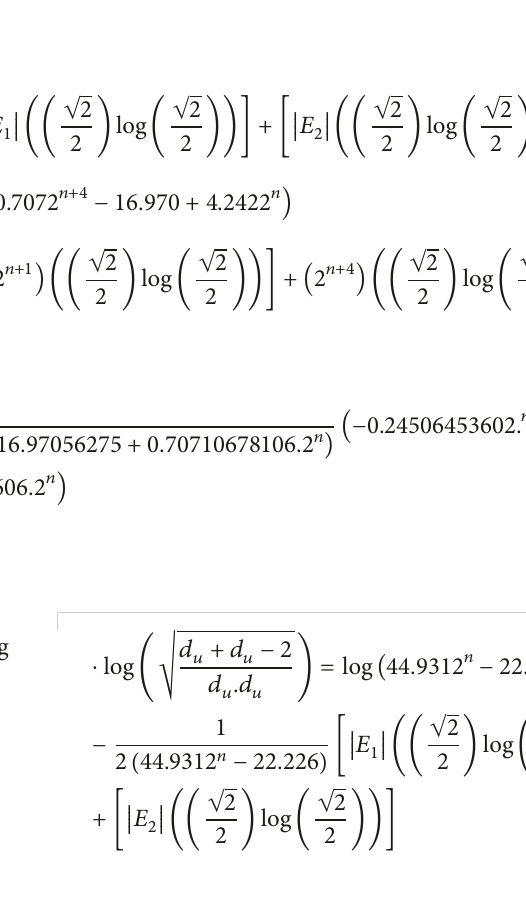
Figure 2: Propyl ether imine